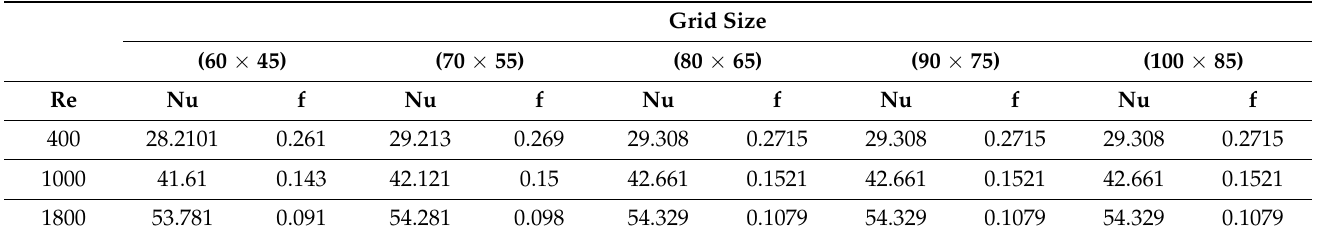
Table 1. The grid independence at φ = 0.5 and different Reynolds number. Grid Size